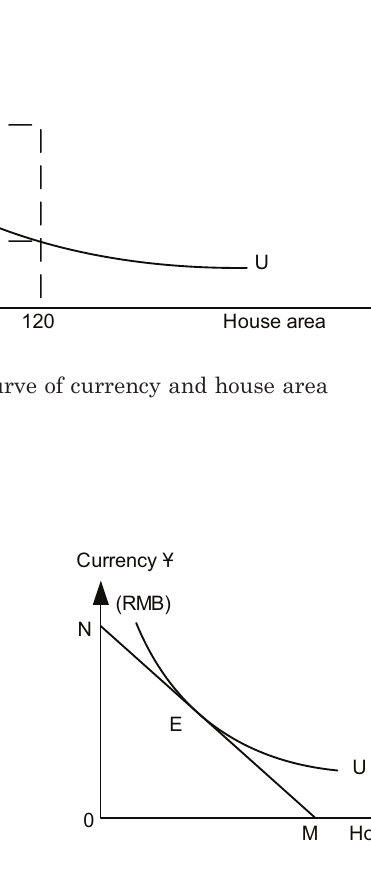
figure 5. a series of indifference curves figure 6. equilibrium point of consumers